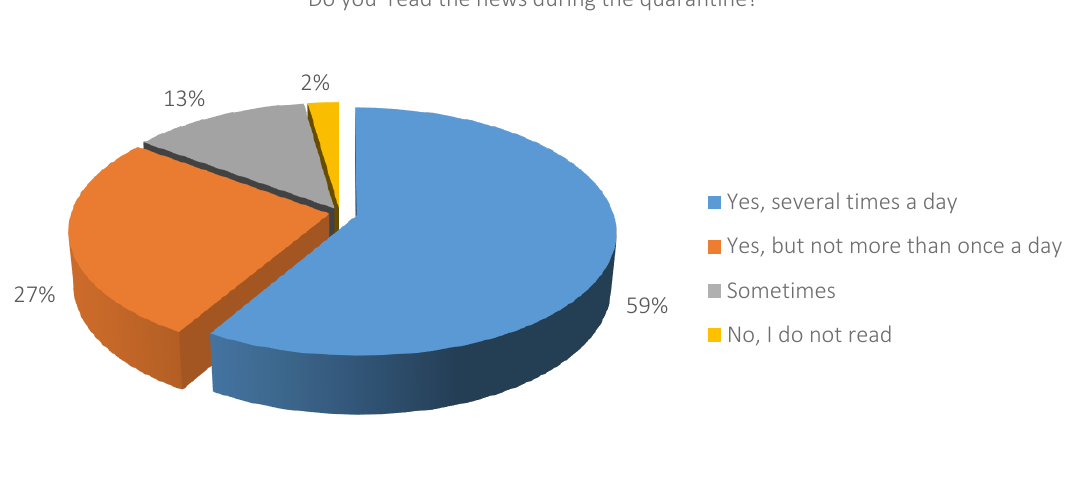
Figure 2. Interest of young Ukrainians in news consumption during the СOVID-19